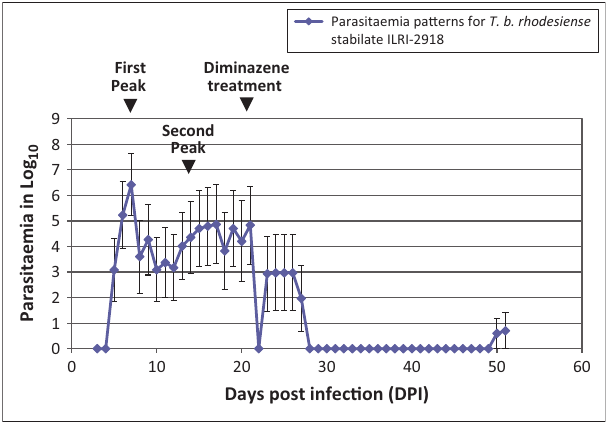
FIGURE 1: Mean parasitaemia pattern for T. b. rhodesiense ILRI-2918 infection in Swiss white mice. The first peak occurred at seven DPI; the second peak occurred at 17 DPI. Mean parasitaemia at the first peak was estimated at Log 6.4. Mean parasitaemia at the second peak was estimated at Log 10 Following treatment at 21 DPI with diminazene aceturate (40 mg/kg ip, Berenil®, Intervet, South Africa), parasitaemia dropped below microscopically-detectable levels between 22 and 28 DPI. Relapse parasitaemia was observed on 50 DPI.